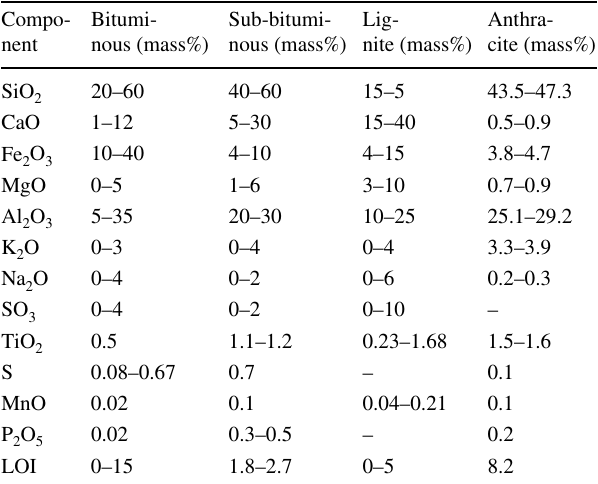
Table 1 Chemical composition of CFA obtained from different type of coals (Gollakota et al. 2019)